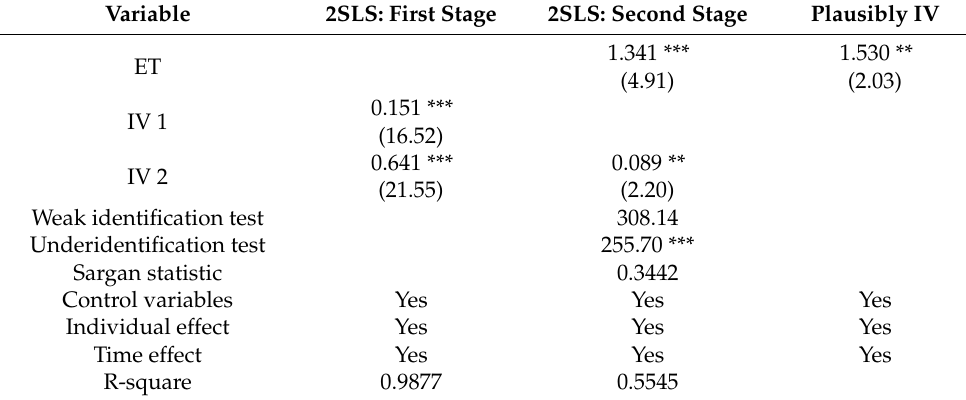
Table 4. Endogenous test